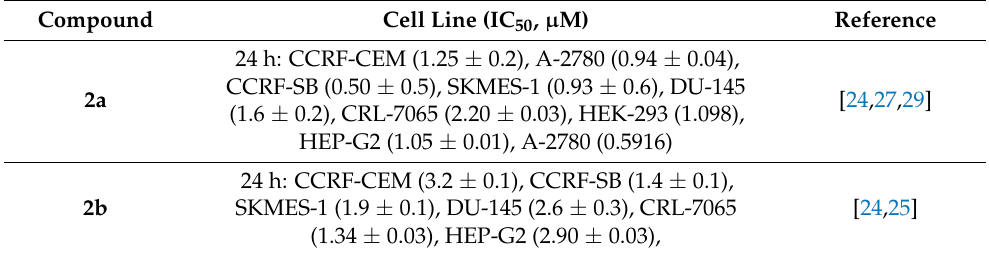
Table 1. IC 50 values of compounds 2a – 3d